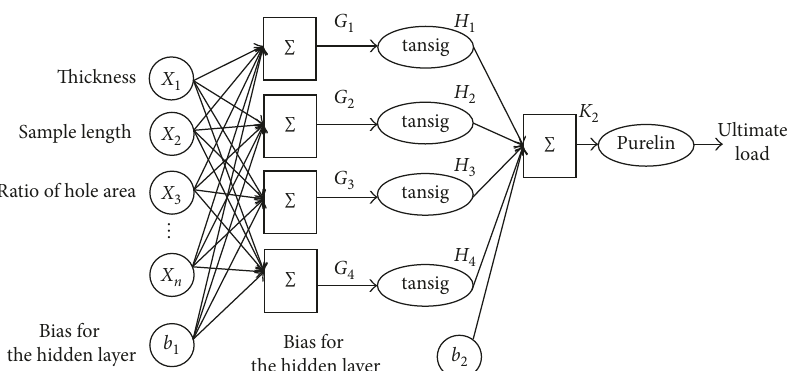
Figure 11: ANN architecture.